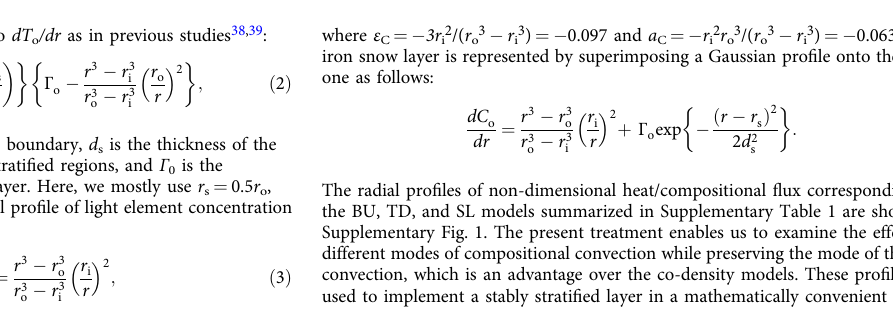
Fig. 5 Time-averaged axisymmetric structures of non-dimensional magnetic and velocity fi elds in the meridional cross-section. From the left, poloidal magnetic fi eld lines, toroidal magnetic fi eld, meridional circulation, and zonal fl ow are drawn, respectively, by contour lines. Red (blue) lines represent positive (negative) values. a BU1, b TD1, c SL1 and d BU1K. In d , plots of the magnetic fi eld are normalized by the maximum